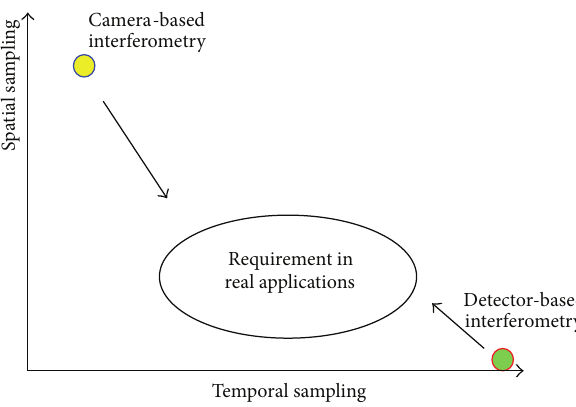
Figure 1: The current status of camera-based and detector-based